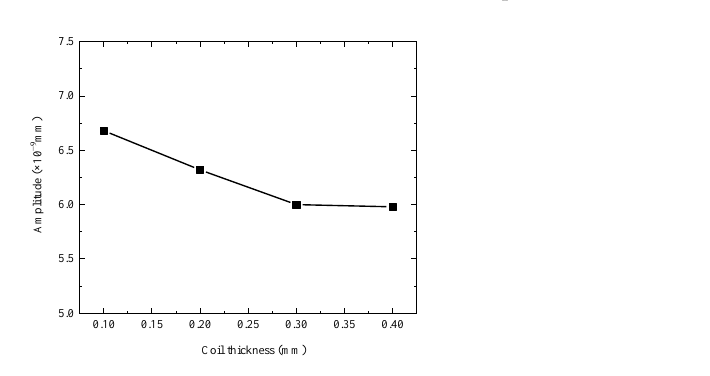
Figure 21. The influence of coil thickness on the amplitude of received signal.